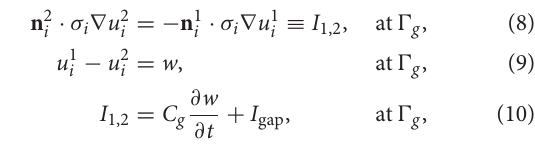
junctions connecting neighboring cells (see, e.g., Tveito et